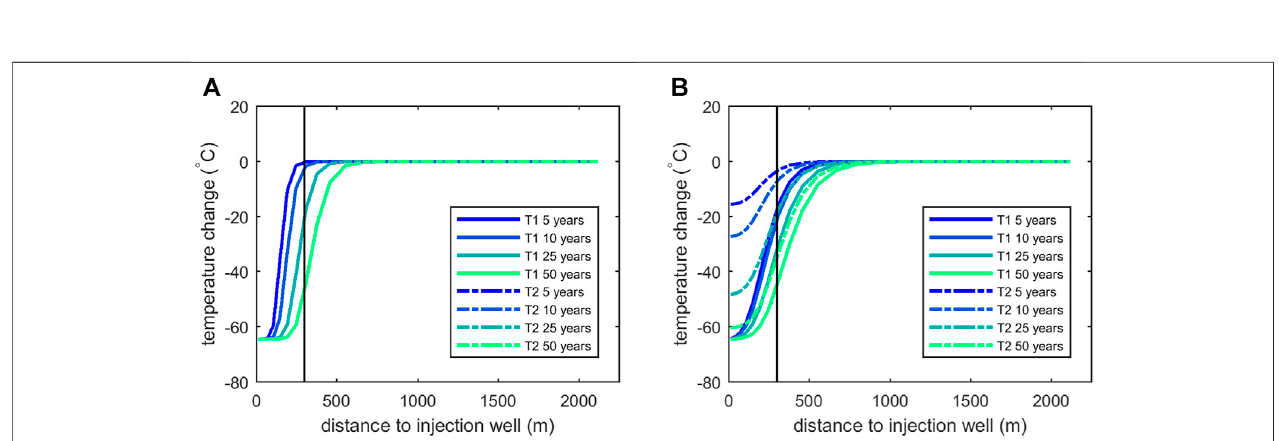
FIGURE 3 | Long-term temperature evolution in the fractures and rock matrix, (A) for fracture distance of 2 m, (B) for fracture distance of 200 m. Solid lines (T 1 ) indicate fracture temperature change, dashed lines (T 2 ) indicate matrix temperature change. The black vertical line represents the horizontal position of the fault, measured at mid-height reservoir